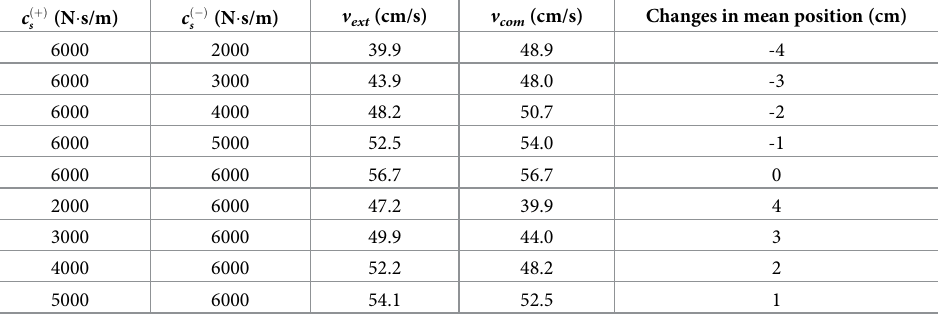
Table 1. The maximum velocities of the vehicle body in the extension travel and compression